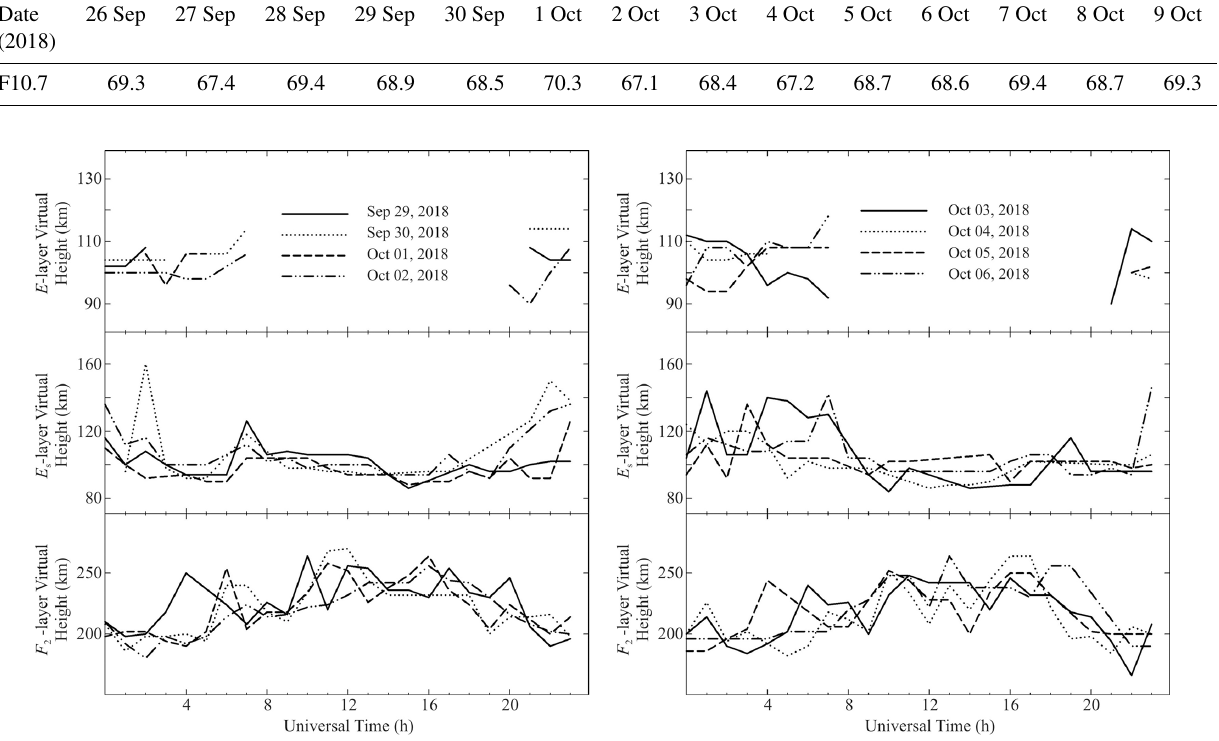
Figure 4. Universal time variations in ionogram parameters determined with an update rate of one measurement per 1h: virtual heights h (cid:48) E , h (cid:48) E , and h (cid:48) F2 for 29 September–2 October and 3–6 October 2018 periods. s